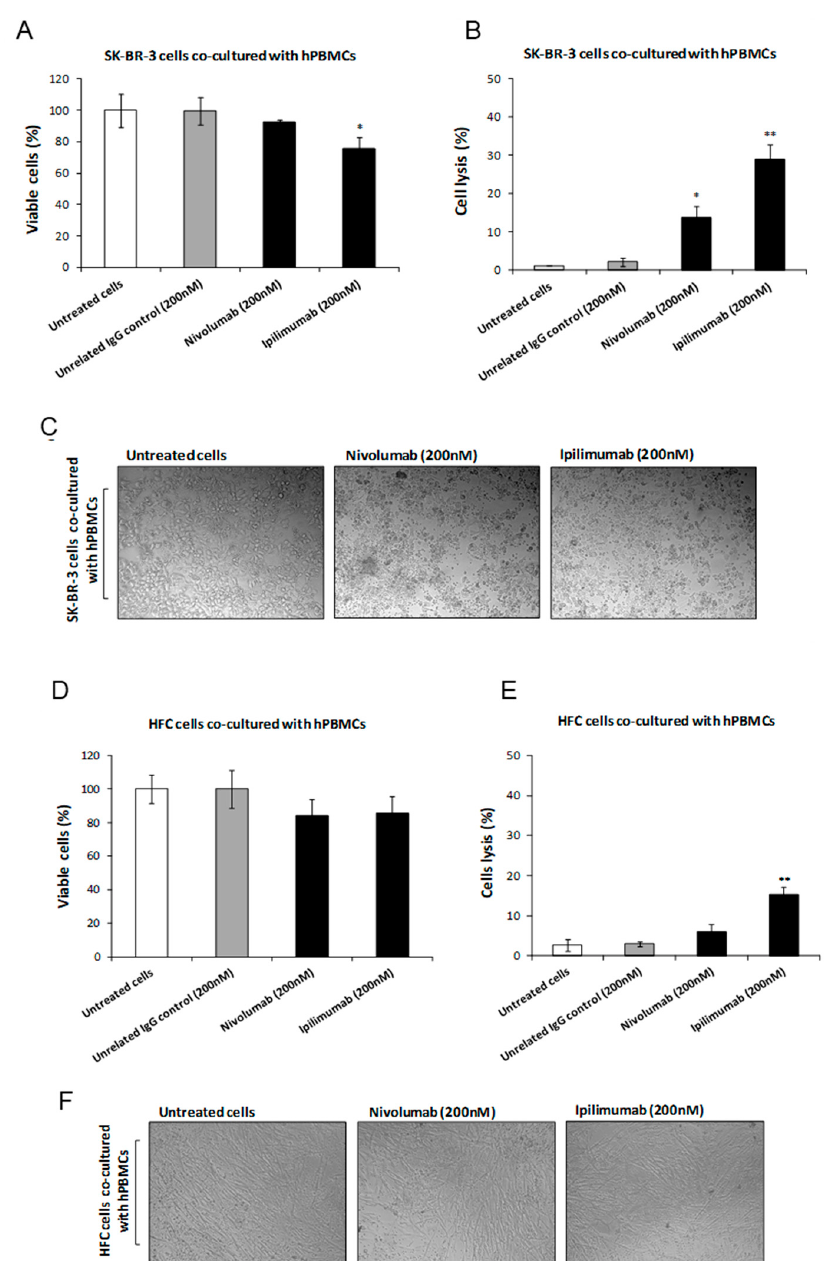
Figure 1. Effects of Nivolumab and Ipilimumab mAbs on SK-BR-3 tumor cells co-cultured with hPBMCs as well as on human cardiomyocytes co-cultured with hPBMCs. ( A ) Cell viability assay on SKBR-3 tumor cells, treated with Nivolumab or Ipilimumab mAb for 24 h, in the presence of hPBMCs. Untreated cells (white bars) or cells treated with an unrelated control Immunoglobulin G (IgG) (grey bars) were used as negative controls. Cells were counted by Trypan blue after the removal of lymphocytes. ( B ) LDH assay on the supernatant of co-cultures treated as indicated. Cell lysis was measured as described in the Materials and Methods section. ( C ) Representative images of SK-BR-3 tumor cells co-cultured with lymphocytes and treated as indicated. ( D ) Cell viability assay on HFC cells, treated with Nivolumab or Ipilimumab mAb for 24 h, in the presence of lymphocytes. Untreated cells (white bars) or cells treated with an unrelated control IgG (grey bars) were used as negative controls. ( E ) LDH assay on the supernatant of co-cultures treated as indicated. Cell lysis was measured as described in the Materials and Methods section. ( F ) Representative images of HFC treated in the presence of lymphocytes. Error bars depict means ± SD. p -values for the indicated compounds relative to untreated cells are: * p < 0.05; ** p < 0.01.